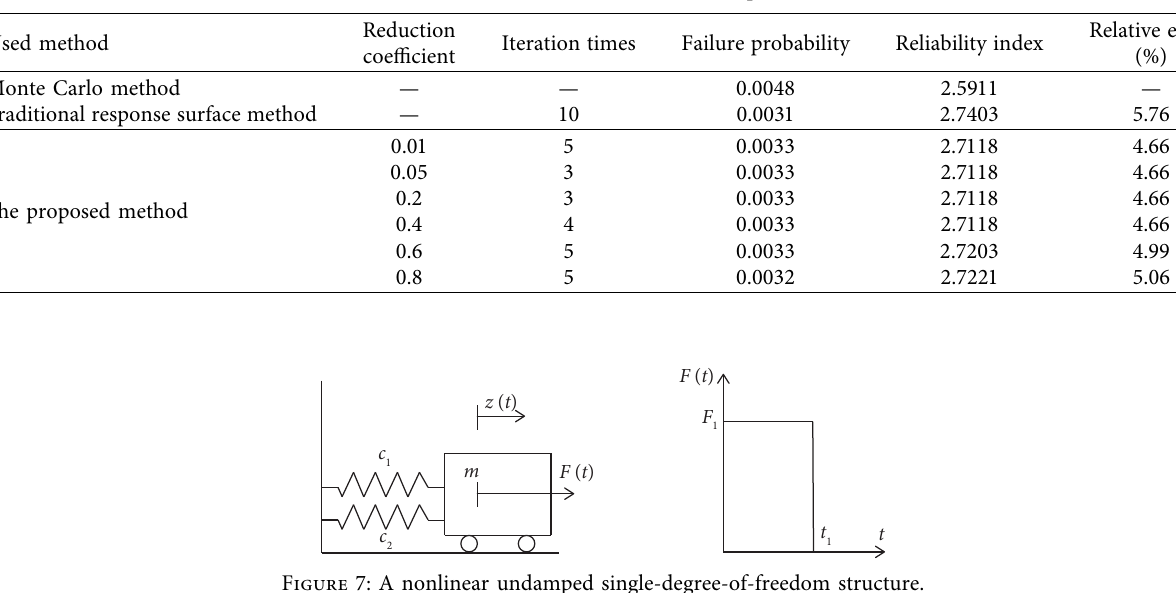
Table 6: Calculation results of example 4.